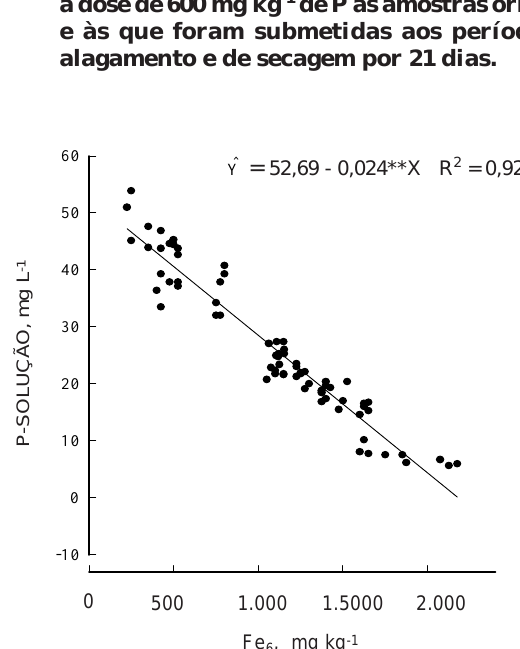
Figura 5. Relação entre os teores de P na solução, após a adição de uma quantidade equivalente à dose de 600 mg kg -1 de P e os teores de ferro extraídos por oxalato de amônio 0,2 mol L -1 , nas amostras dos seis solos, originais e após submetidas aos períodos de alagamento e de secagem por 21